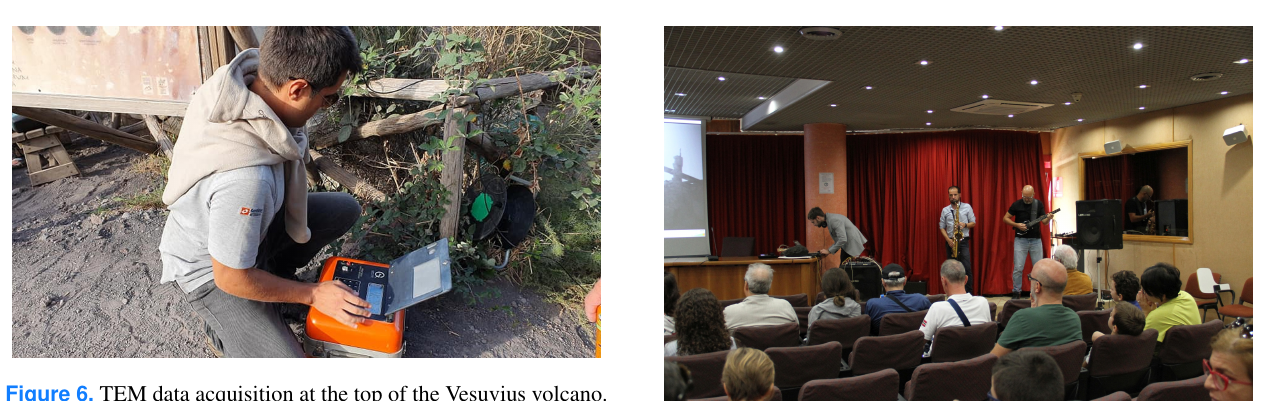
Figure 6. TEM data acquisition at the top of the Vesuvius volcano.